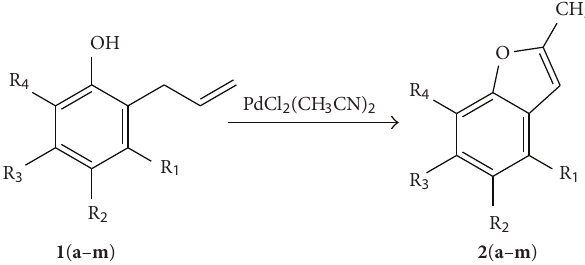
5-Bromo-2-methyl Benzofuran (2a) . Yield